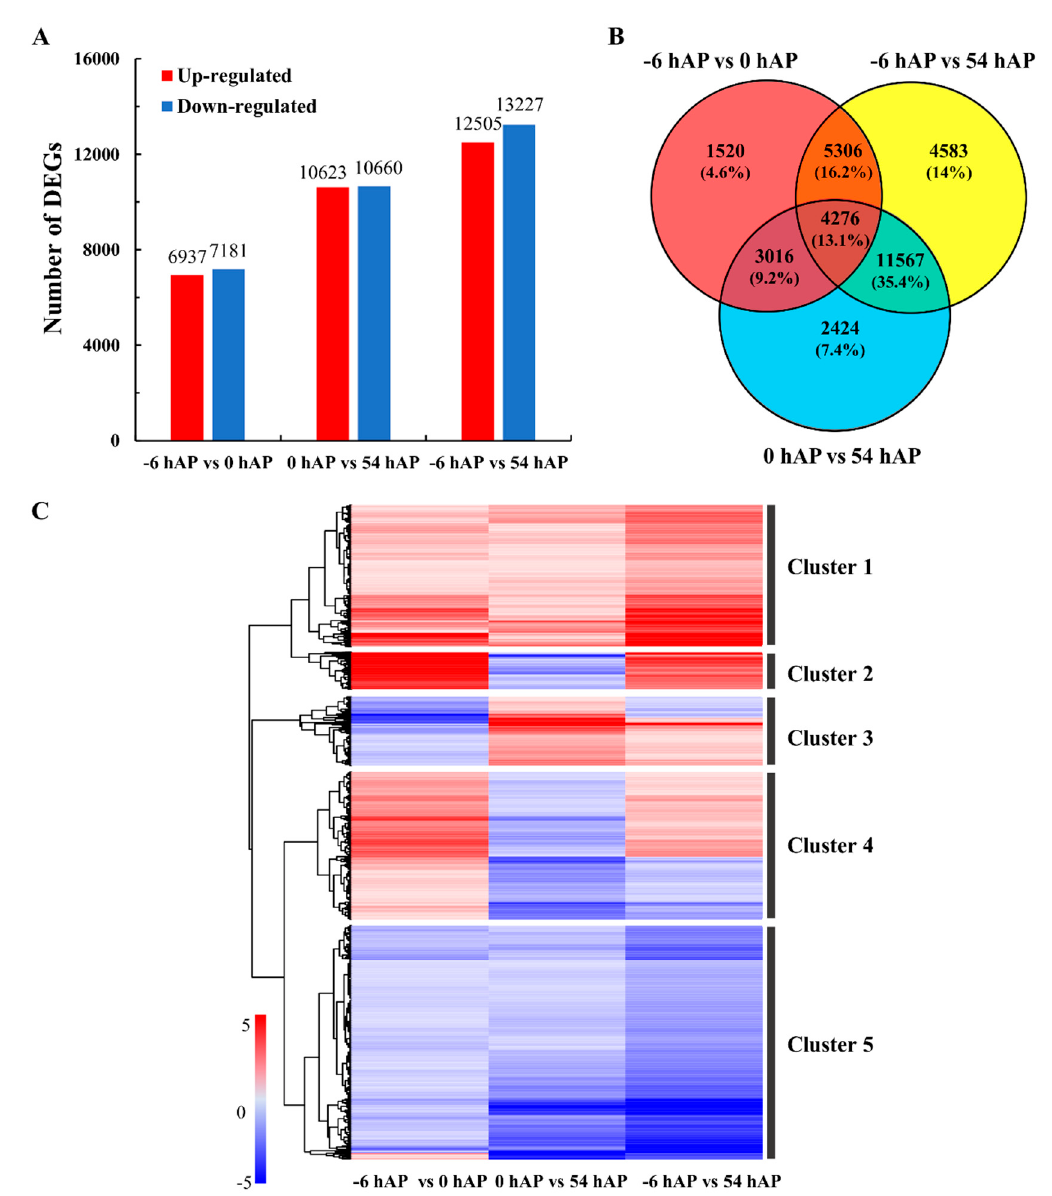
Figure 2. Differentially expressed genes (DEGs) from RNA-seq during the early phases of AR formation in mulberry stem hardwood cuttings. The number of DEGs in the three time point comparison groups ( − 6 hAP vs. 0 hAP, 0 hAP vs. 54 hAP, − 6 hAP vs. 54 hAP) ( A ), the Venn diagram presentation of the overlapped DEGs ( B ), and the hierarchical clustering analysis of the 4276 common DEGs based on data of log 2 Ratio for each gene ( C ), are presented. The common genes are divided into five clusters. The color bar, ranging from blue to red, indicates low to high changes of transcriptional expression level from − 5 to 5.